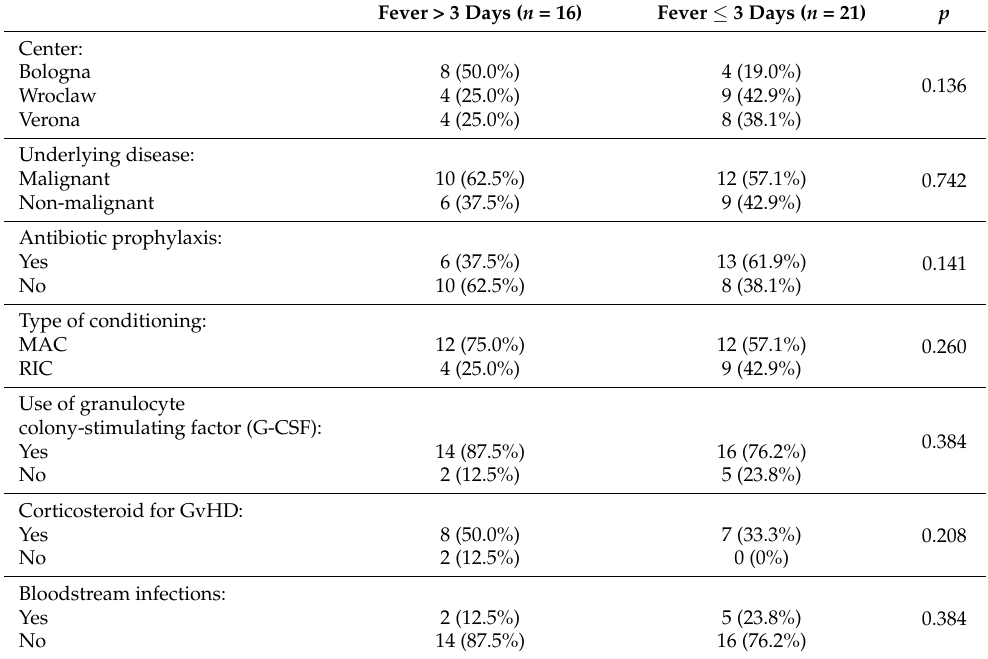
Table 2. Comparison of clinical confounders between patients with longer and shorter duration of neutropenic fever. BM: Bone marrow; EN: Enteral nutrition; MAC: Myeloablative conditioning; MMUD: Mismatched unrelated donor; MSD: Matched sibling donor; MUD: Matched unrelated donor; PBSC: Peripheral blood stem cells; PN: Parenteral nutrition; RIC: Reduced intensity conditioning. Qualitative clinical variables were compared using Fisher’s exact or Pearson’s chi-square